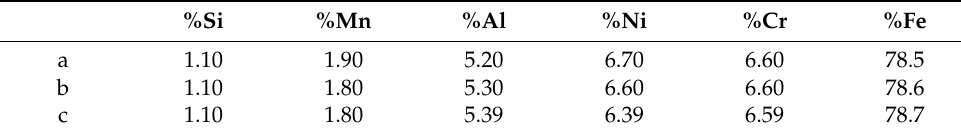
Figure 1. Scanning electron microscope micrograph of weld metal areas marked a, b, and c (see Table 4 below, indicating the analyses per marked phase area: a, b, and c) (×3000). Table 4 below, indicating the analyses per marked phase area: a, b, and c) ( × 3000). Table 4. SEM-EDS analyses of areas a, b, and c in Figure 1 (mass%). Table 4. SEM-EDS analyses of areas a, b, and c in Figure 1